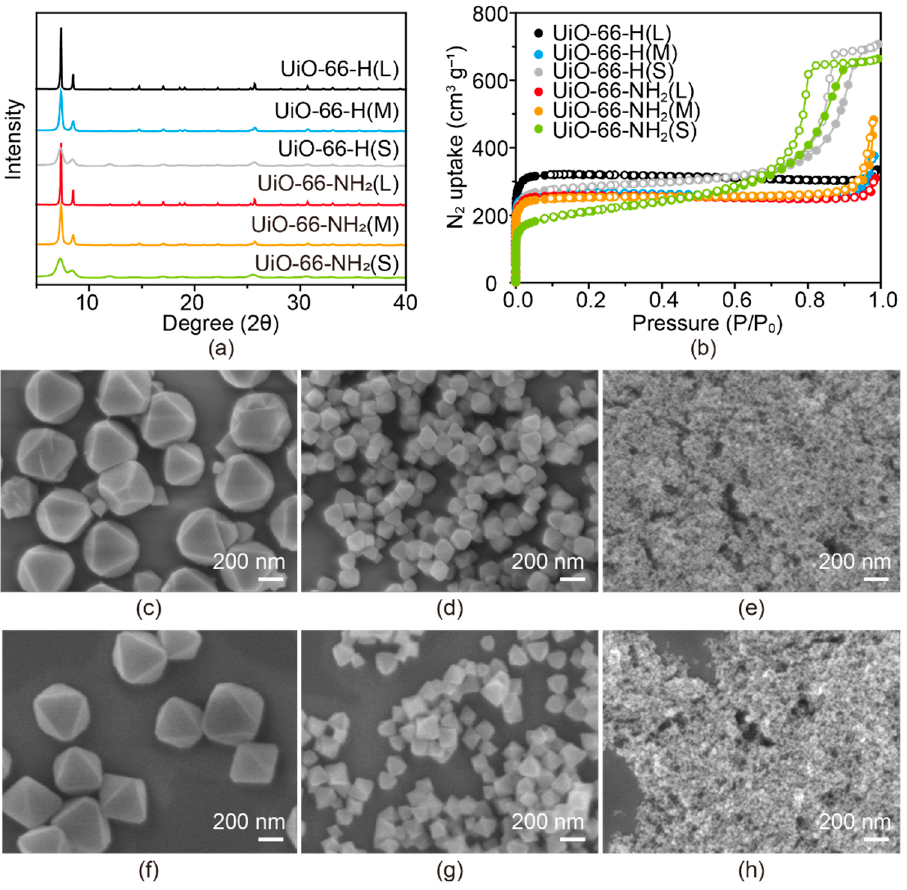
Figure 2. Characterizations of UiO-66-H(X) and UiO-66-NH 2 (X): ( a ) PXRD patterns; ( b ) N 2 adsorption-desorption isotherms. SEM images of ( c ) UiO-66-H(L), ( d ) UiO-66-H(M), ( e ) UiO-66-H(S), ( f ) UiO-66-NH 2 (L), ( g ) UiO-66-NH 2 (M), and ( h ) UiO-66-NH 2 (S).